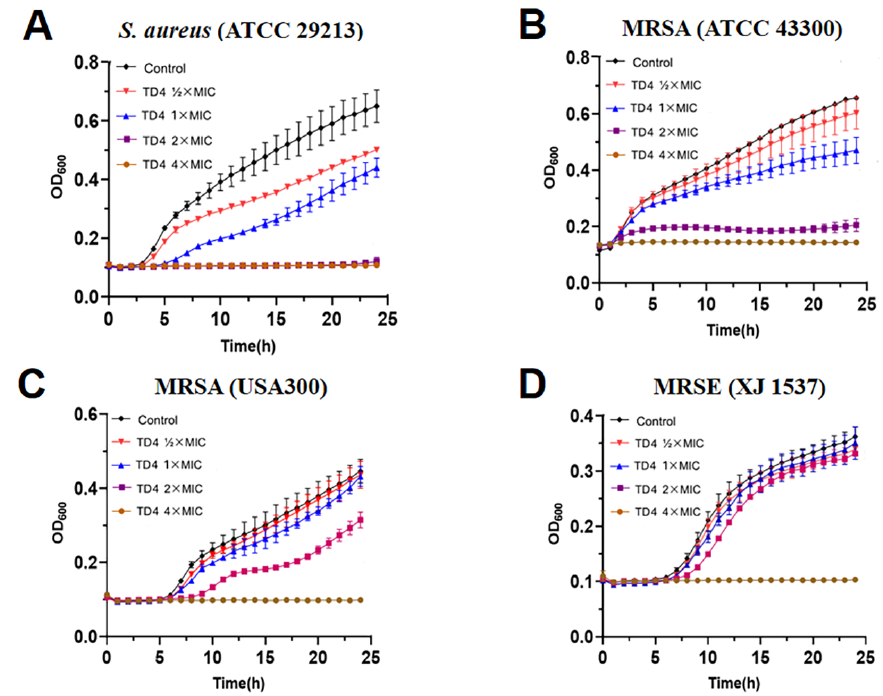
Figure 1. TD4 inhibited the growth curves of ( A ) S. aureus (ATCC 29213), ( B ) MRSA (ATCC 43300), ( C ) MRSA (USA 300) and ( D ) MRSE (XJ 1537) in a concentration-dependent